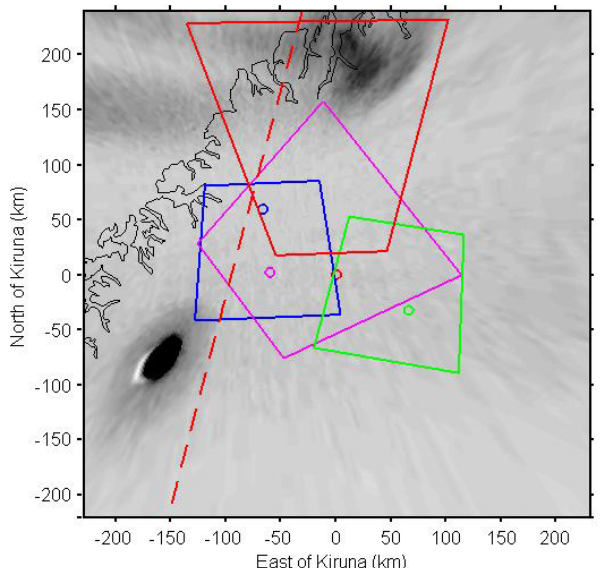
Fig. 1. Geography of the experiment. The coordinate system is a cartesian system centred in Kiruna. The X-axis is directed to ge- ographic East, the Y-axis to geographic North. The background is the FMI camera image projected to 110km (Negative). Colour cir- cles and frames indicate location and field of view of ALIS cameras projected to 110km. Red – Kiruna, magenta – Nikkaluokta, blue – Abisko, green – Silkkimuotka. The dashed red line is the FAST magnetic footprint at 110km. The black spot in the lower left sec- tion of the figure is the